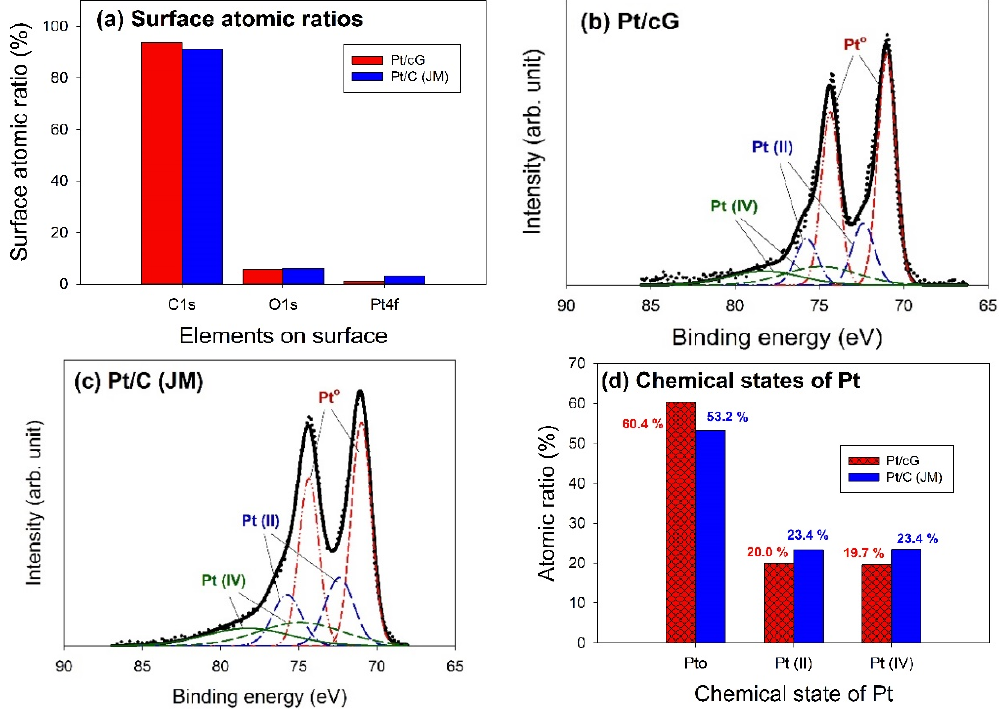
Figure 6. Curve fitting of high-resolution XPS Pt4f spectra for the samples. ( a ) Surface atomic ratios; ( b ) Pt/cG; ( c ) Pt/C (JM); ( d ) Chemical states of Pt.